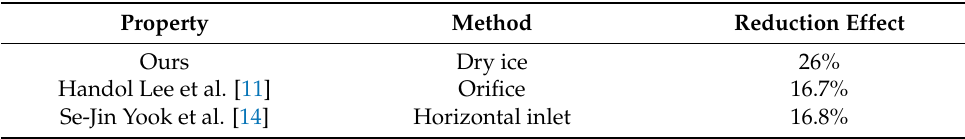
Figure 16. New virtual impactor collection efficiency curve. Table 2. Parameter design of new virtual impactor.